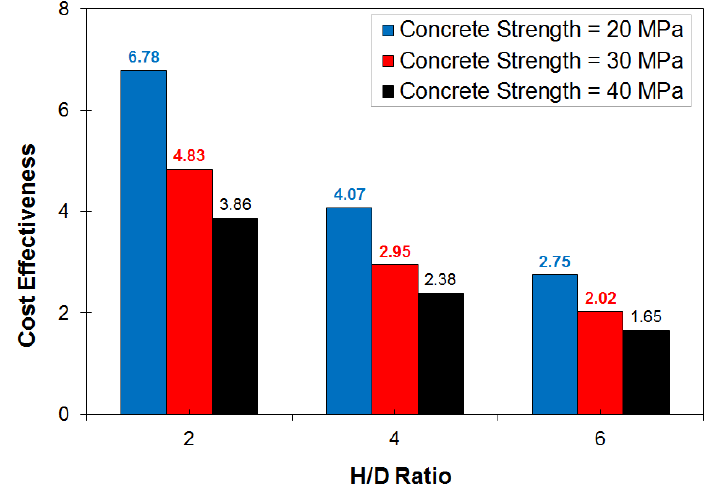
Figure 8. Cost effectiveness of the SFRP confined concrete columns with varying slenderness ratios and concrete